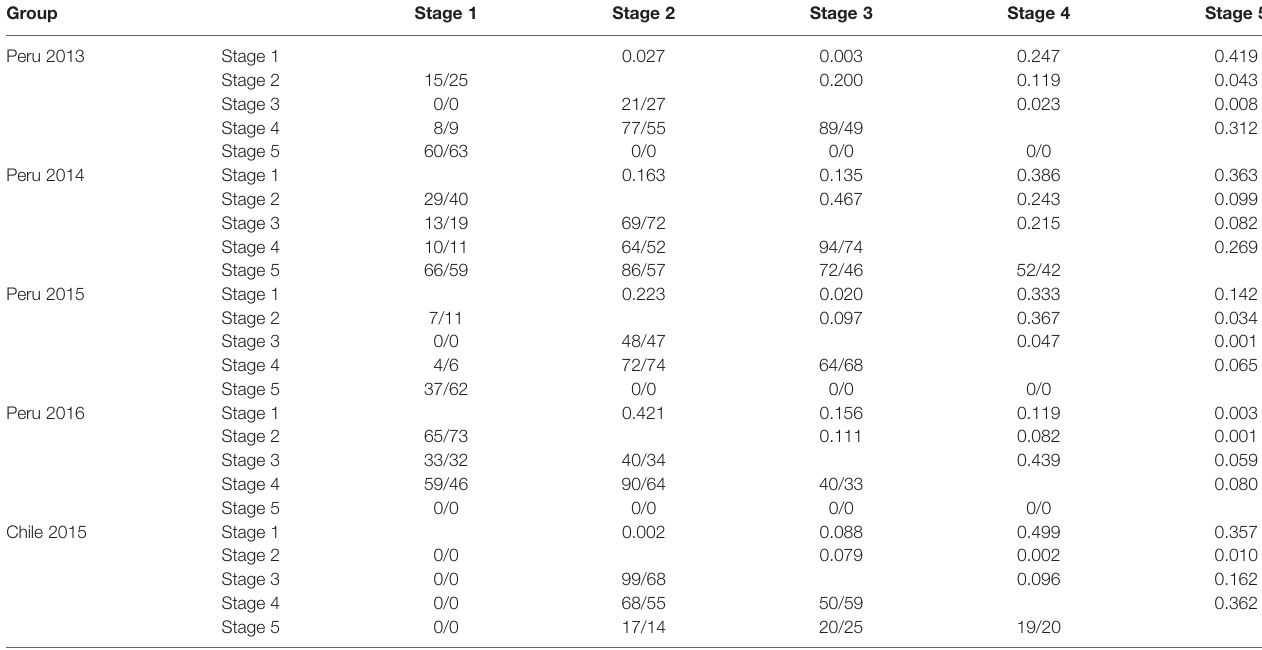
Foreachgroup,bottomleftvaluesarepercentagesofSEAcoverlaps(the fi rstvalueistheoverlapoftheyoungerstageovertheolderstage,andthesecondvalueistheoverlapoftheolder stage over the younger stage), and top right values are p -values of SEAc comparisons. “ Peru 2013 ” represents the samples collected off Peru during 2013, and so